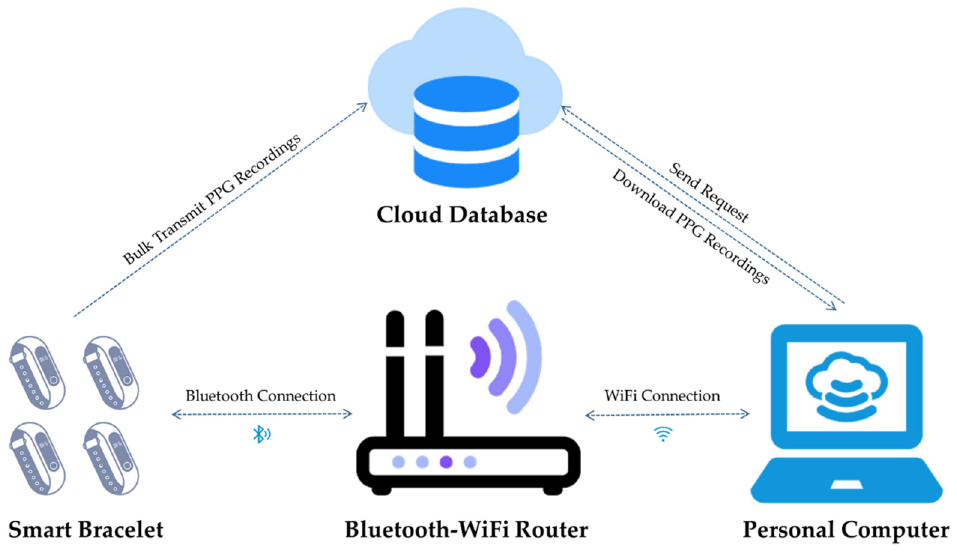
Figure 1. Self-designed smart bracelet system.